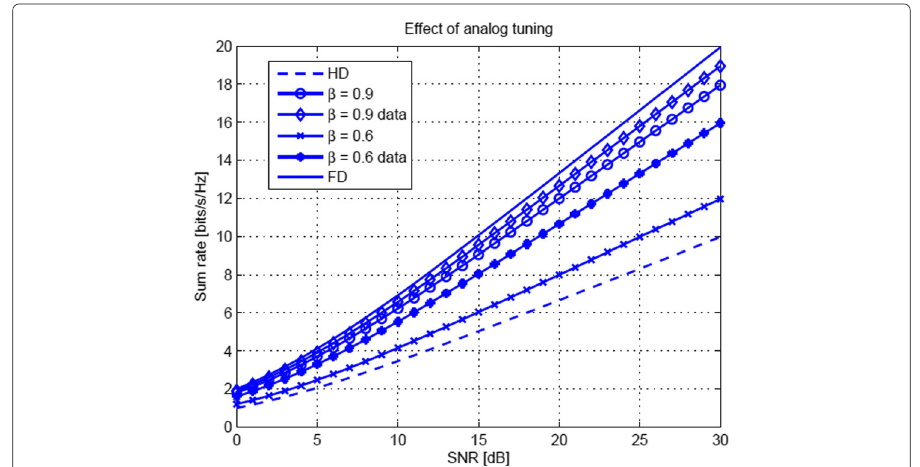
Fig. 11 FD link sum rate vs. SNR for different FD transmission/tuning time ratios